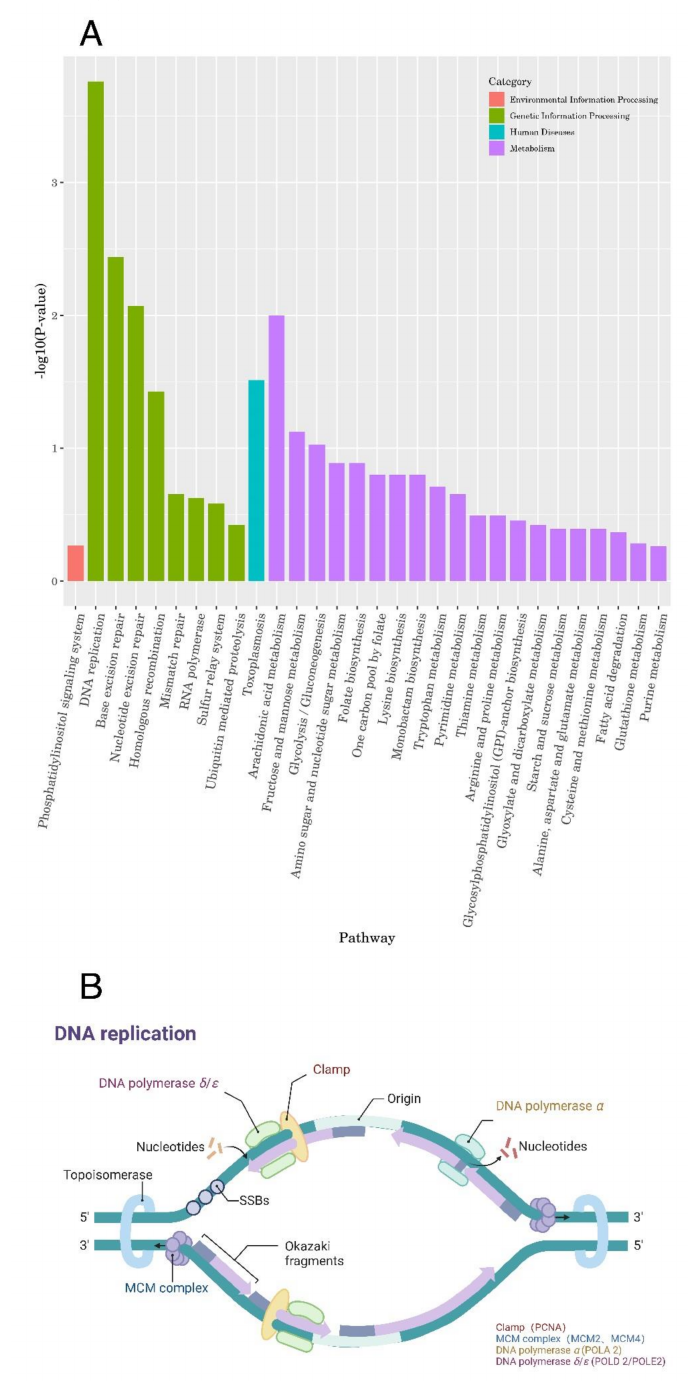
Figure 3. Transcriptome data suggests that lumefantrine interfered with T. gondii DNA replication. ( A ) The classification of the thirty enriched pathways. The top thirty most enriched pathways were grouped into four categories, namely, environmental information processing, genetic information processing, human diseases, and metabolism. ( B ) The seven genes that were upregulated in the DNA replication pathway. We illustrated the component of DNA replication using BioRender (created with BioRender com). The red components were proteins that were encoded by the upregulated genes identified in this